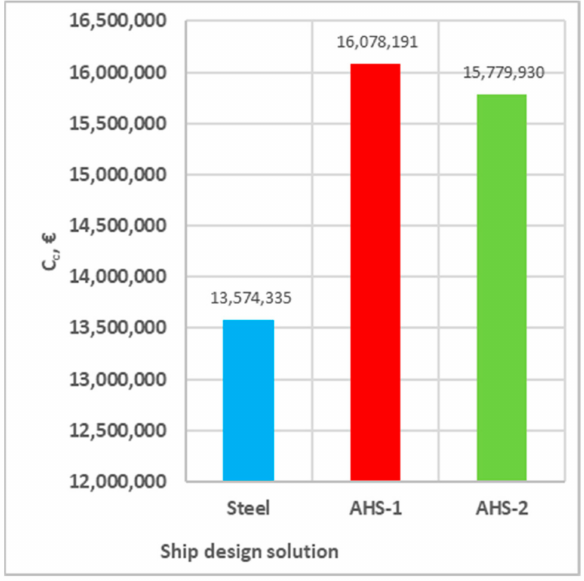
Figure 6. Cost of loss of